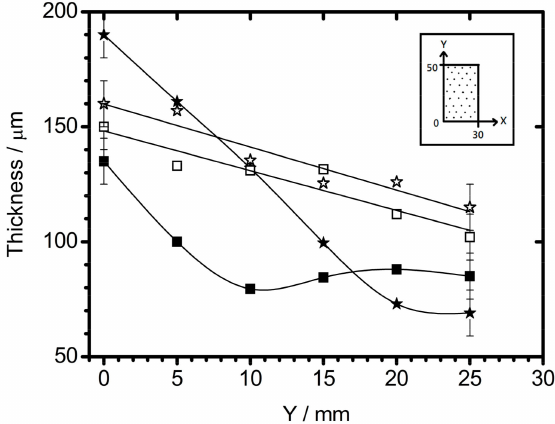
Figure 7. Coating thickness distribution of a rectangular disk sample [83]. Coating thickness is plotted versus position parameter Y , along the center line at X = 15 mm for two electrode gaps, 8.5 mm ( (cid:4) / (cid:3) ) and 118.5 mm ( ). Data points of soft sparking ( R pn = 0.89) are marked with open symbols, those of conventional arcing ( R pn = 1.57) are marked with close symbols. PEO time is 40 min with 100 Hz bipolar pulsed current at anodic current density 92 A · dm − 2